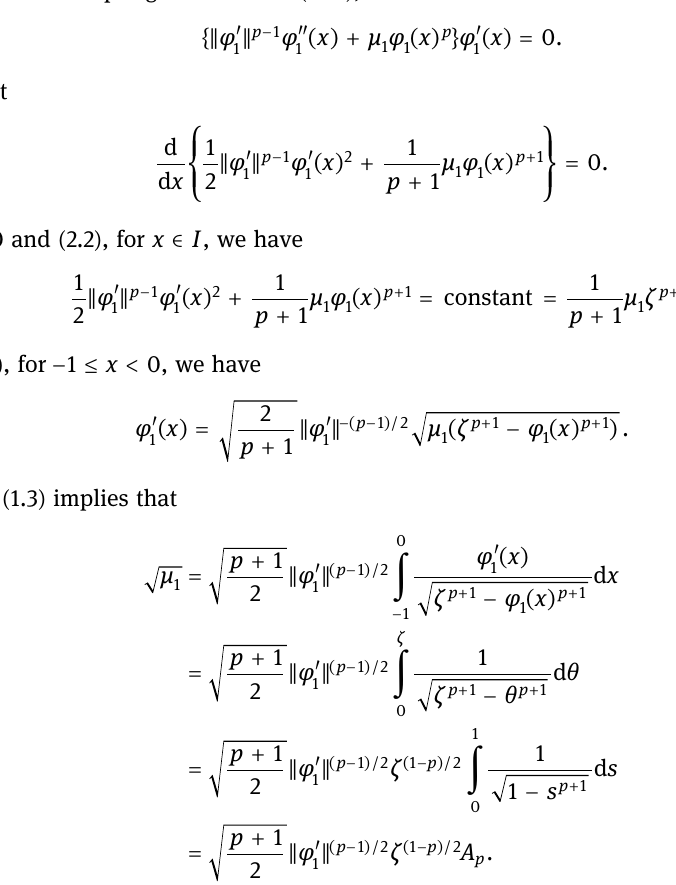
Figure 5: The graph of λ ξ ( ) for p 1 =